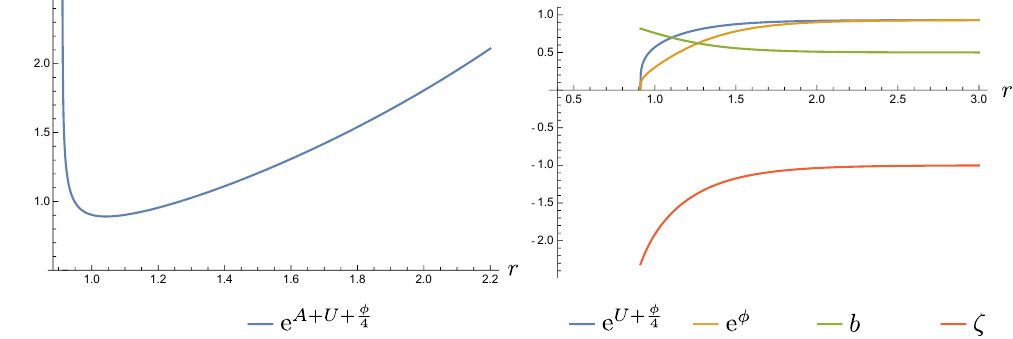
vacuum. 2 6 in the φ ). These ones, together with 4